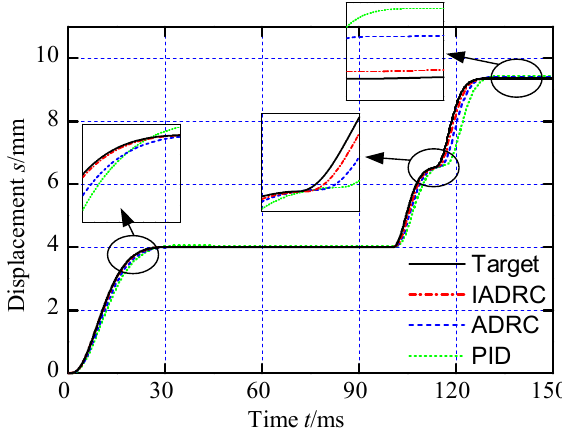
Figure 14. Comparison of displacement tracking performance.